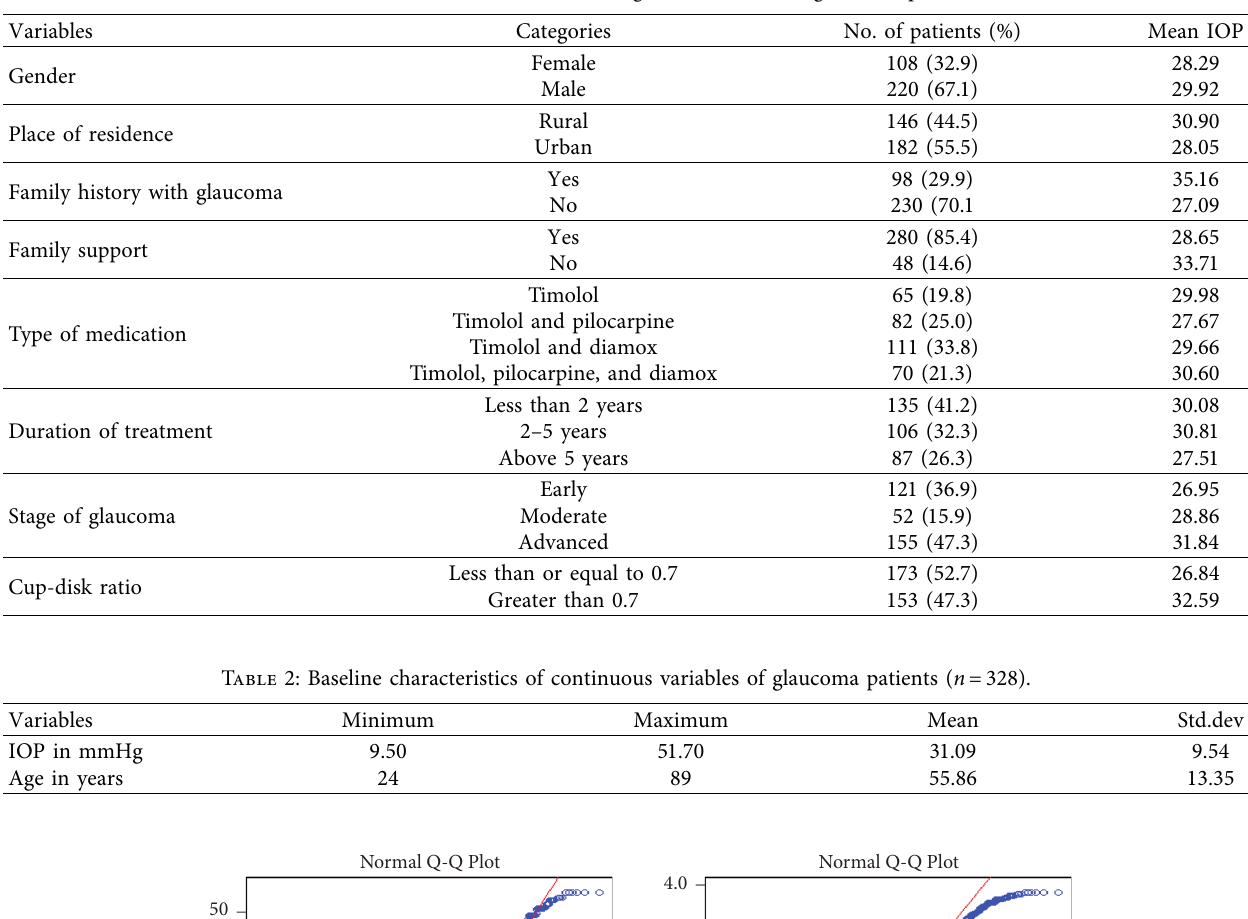
Table 1: Baseline characteristics of categorical variables of glaucoma patients.